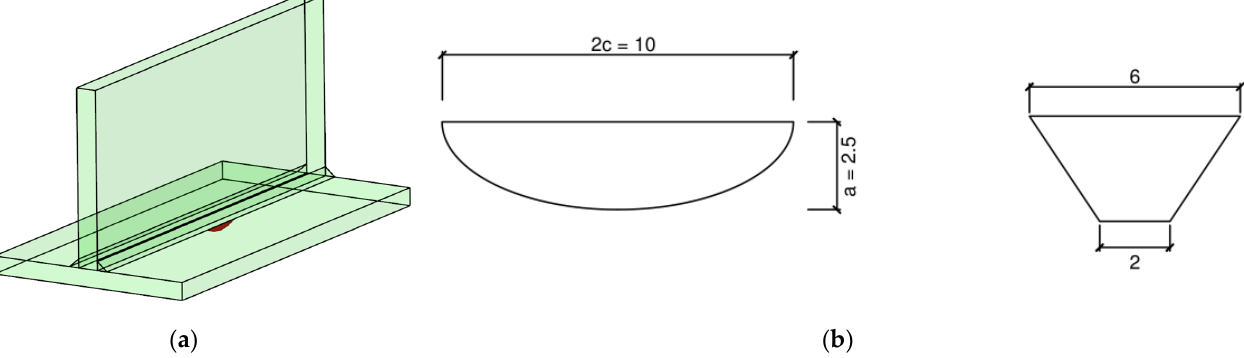
Figure 14. Initial Crack Location and Shape: ( a ) Crack Location; ( b ) Crack Shape (unit: mm).